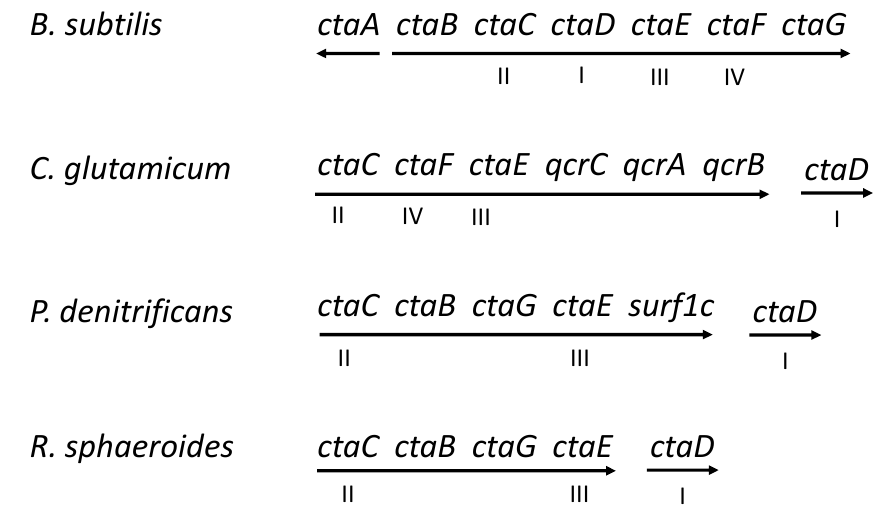
Figure 2. Organization of genes for family A1 cytochrome c oxidase in the chromosome of four model bacteria. Arrows show the transcription units. The genes for oxidase polypeptides are indicated I, II, III, and IV. The qcr genes encode the polypeptides of the cytochrome bc complex. The ctaG genes of B. subtilis and P. denitrificans encode different types of proteins, i.e., Caa3_CtaG and Cox11_CtaG, respectively (see